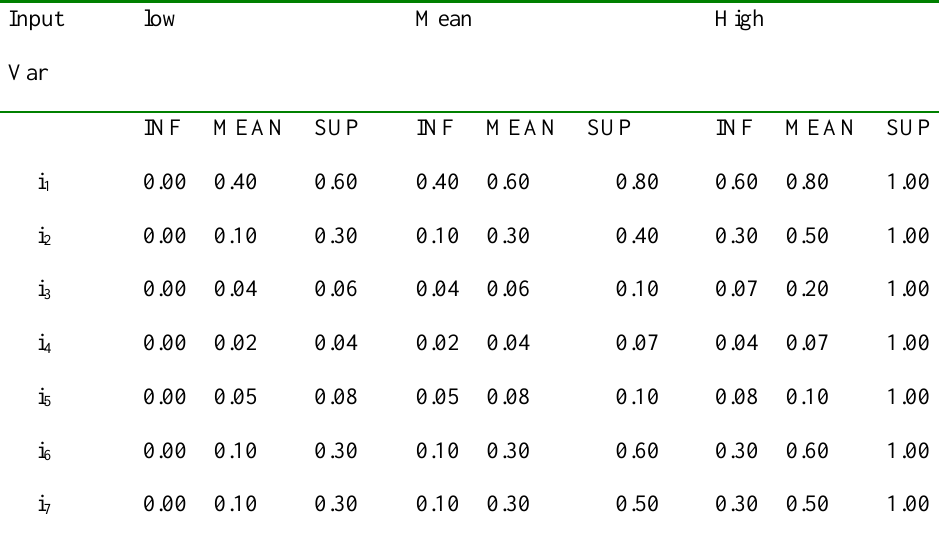
Table 3 . TFNs values for the input domains